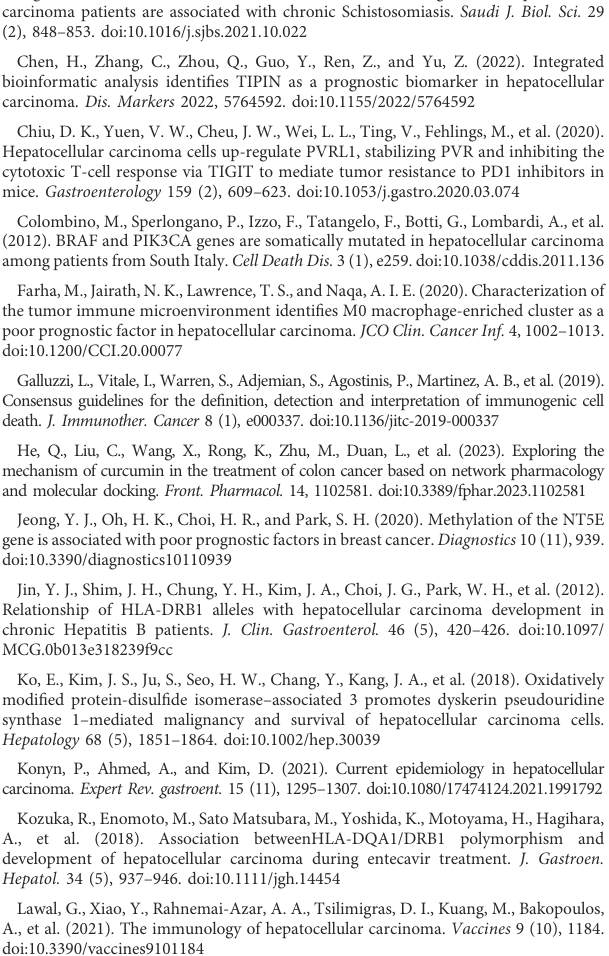
Correlation analysis of ICD associated DEGs and related clinical characteristics. ( (A) age, (B) gender, (C) N stage, (D) M stage, (E) BMI, (F) AFP, (G) Tstage, (H) pathologicstage, (I) vascularinvasion, (J) race, (K) histologic grade, (L) fi brosis ishak score, (M) residual tumor; ICD: Immunogenic cell death, DEGs: Differentially expressed genes; ns: p ≥ 0.05, *: p < 0.05, **: p < 0.01, ***: p <